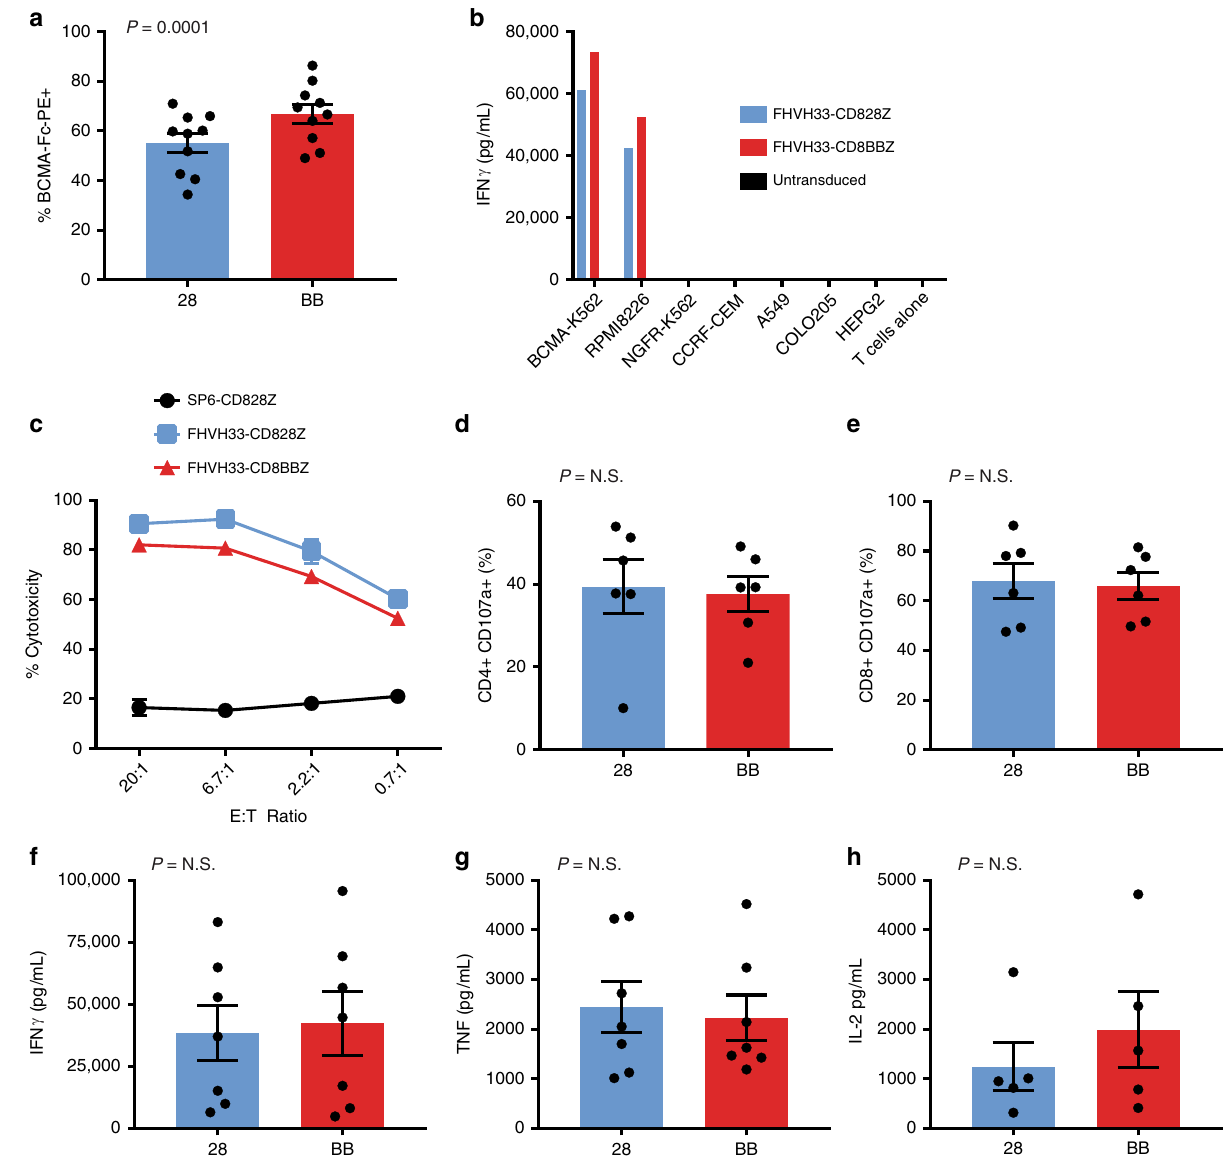
Fig. 4 FHVH33 CARs with either a CD28 or 4-1BB costimulatory domain have similar in vitro function. a T cells from ten donors were transduced with either FHVH33-CD828Z (28) or FHVH33-CD8BBZ (BB). Four or 5 days after transduction, T cells were stained with anti-CD3 and BCMA-Fc-PE to detect CAR-expressing T cells. The mean ± s.e.m. of the percentages of T cells expressing each CAR is shown. All statistical comparisons in this fi gure were by paired two-tailed t -test. P < 0.05 was considered statistically signi fi cant. b T cells expressing either FHVH33-CD828Z or FHVH33-CD8BBZ or left untransduced were cultured overnight with the target cells indicated, and IFN γ was measured in the culture supernatant by ELISA. BCMA-K562 and RPMI8226 were BCMA + ; the other cell lines were BCMA − . Bars represent the means of duplicate wells. The bars representing cultures including untransduced T cells and cultures with BCMA-negative target cells are not visible because the values are too small. Seven experiments with similar results were conducted. c T cells expressing either FHVH33-CD828Z, FHVH33-CD8BBZ, or the control CAR SP6-CD828Z were tested in a 4-h cytotoxicity assay. Two experiments with similar results were conducted. Symbols represent means of duplicate wells ±s.e.m. Degranulation of CD4 + d or CD8 + e T cells was measured by detecting CD107a upregulation with fl ow cytometry ( n = 6). The percentages of T cells with CD107a upregulation after a 4-h culture with RPMI8226 cells minus background CD107a upregulation after culture with NGFR-K562 cells are shown. Release of f IFN γ , g TNF, and h IL-2 after overnight culture with RPMI8226 cells minus background cytokine production after culture with NGFR-K562 cells is shown ( n = 7 for IFN γ and TNF, n = 5 for IL-2). For d – h , the mean ± s.e.m. are shown; results are normalized for CAR expression; N.S, not statistically signi fi cant. P < 0.05 was considered statistically signi fi